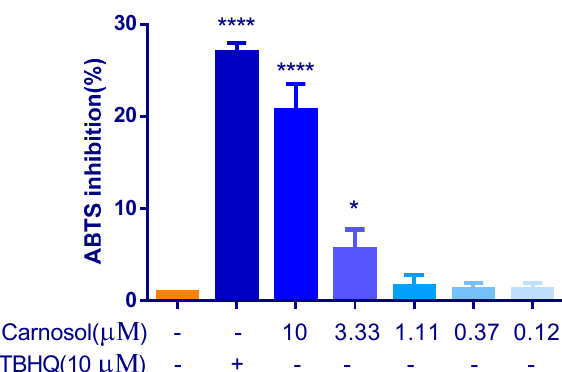
Figure 2. Detection of antioxidant activity of carnosol by ABTS radical scavenging activity. * p < 0.05, **** p < 0.0001, 0.25% DMSO-treated as negative control group, TBHQ (10 µ M) was used as a positive control group, compared with negative group. Results are expressed as mean ± SD ( n = 3).